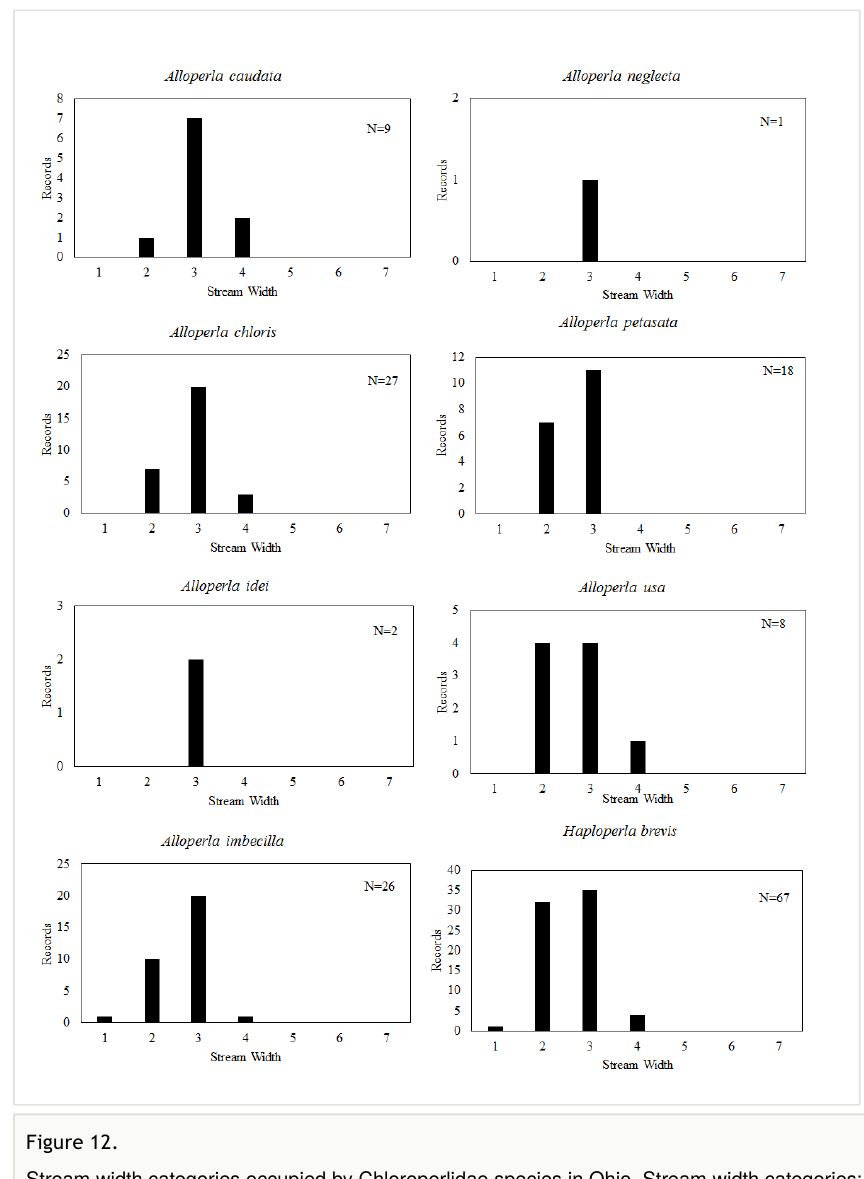
Figure 12. Stream width categories occupied by Chloroperlidae species in Ohio. Stream width categories: 1=seep, 2=1-2 m, 3=3-10 m, 4=11=30 m, 5=31-60 m, 6=>60 m, 7=Lake